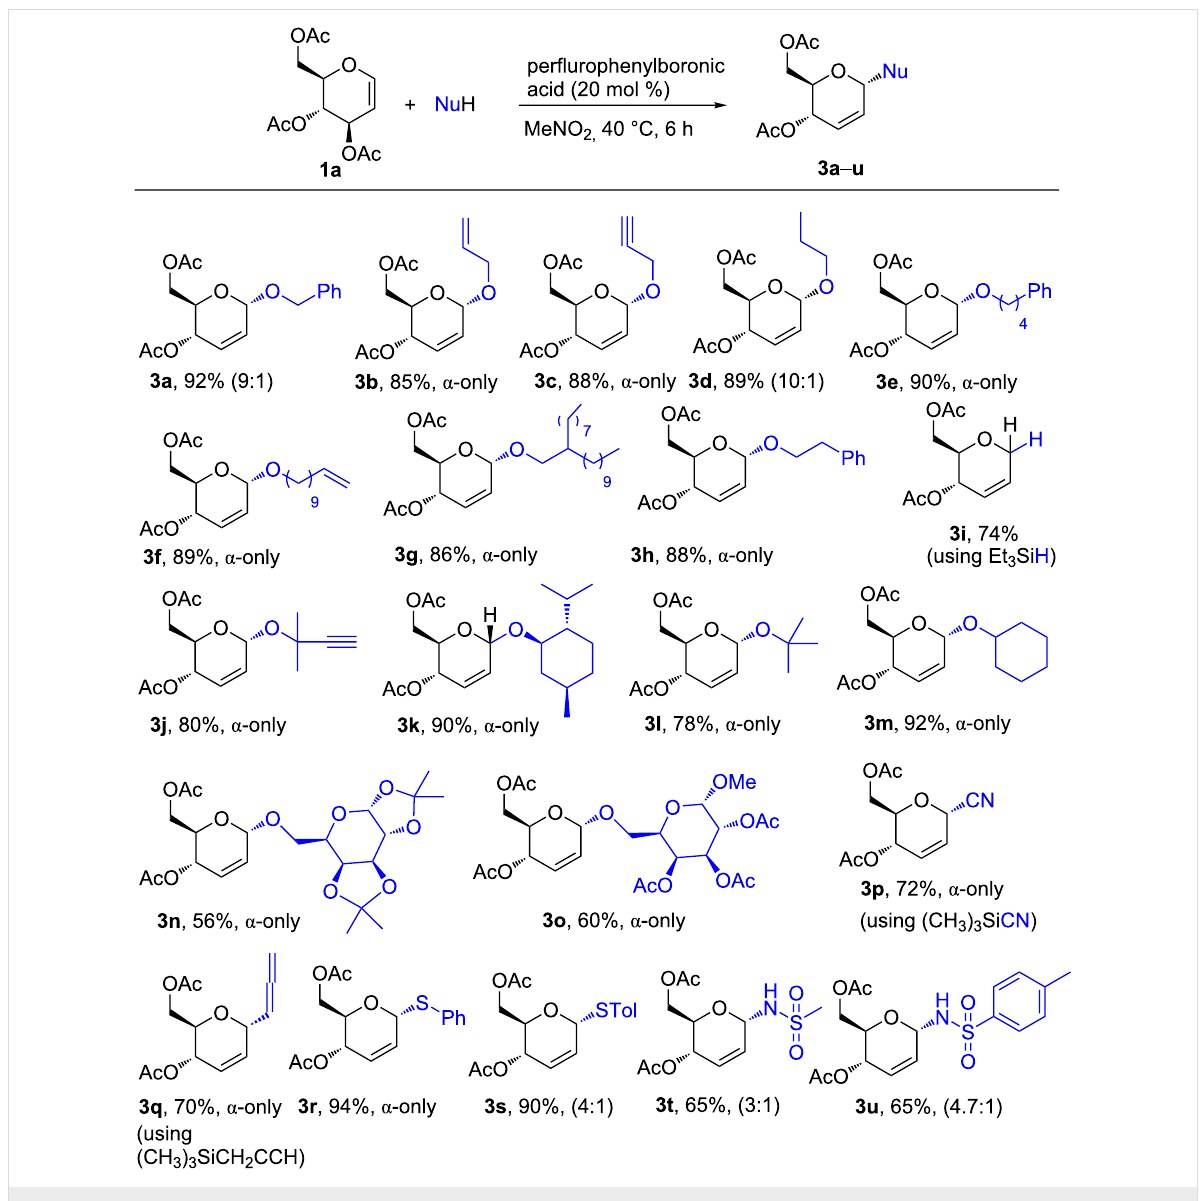
Figure 1: Perfluorophenylboronic acid-catalyzed reaction between 3,4,6-tri- O -acetyl-D-glucal 1a and O- , C-, S -, N -nucleophiles.